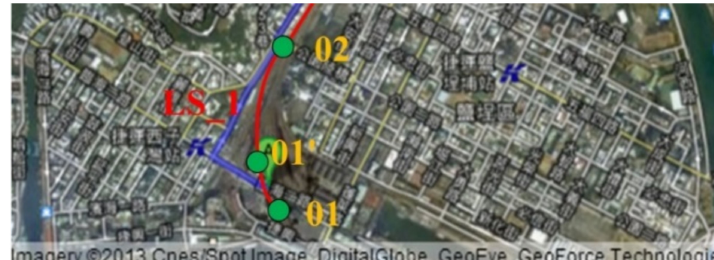
Figure 17. Photographs of the candidate locations for FCI 01 and FCI 02